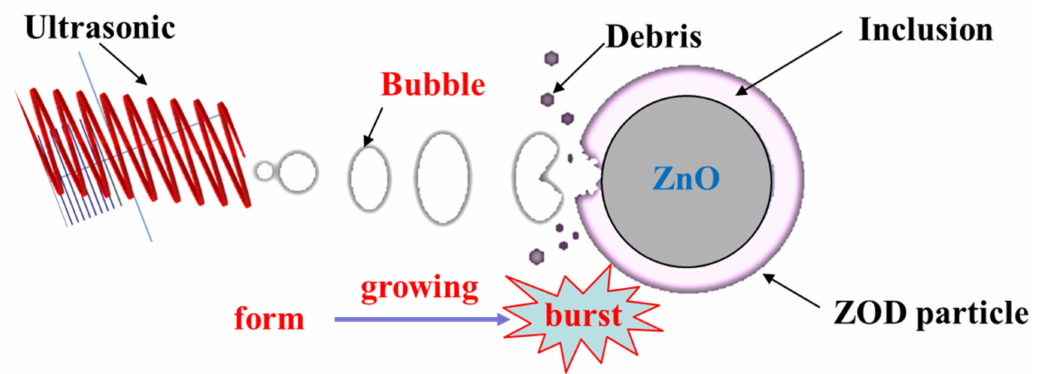
Figure 17. The schematic diagram of the leaching mechanism of ultrasonic-enhanced ZOD